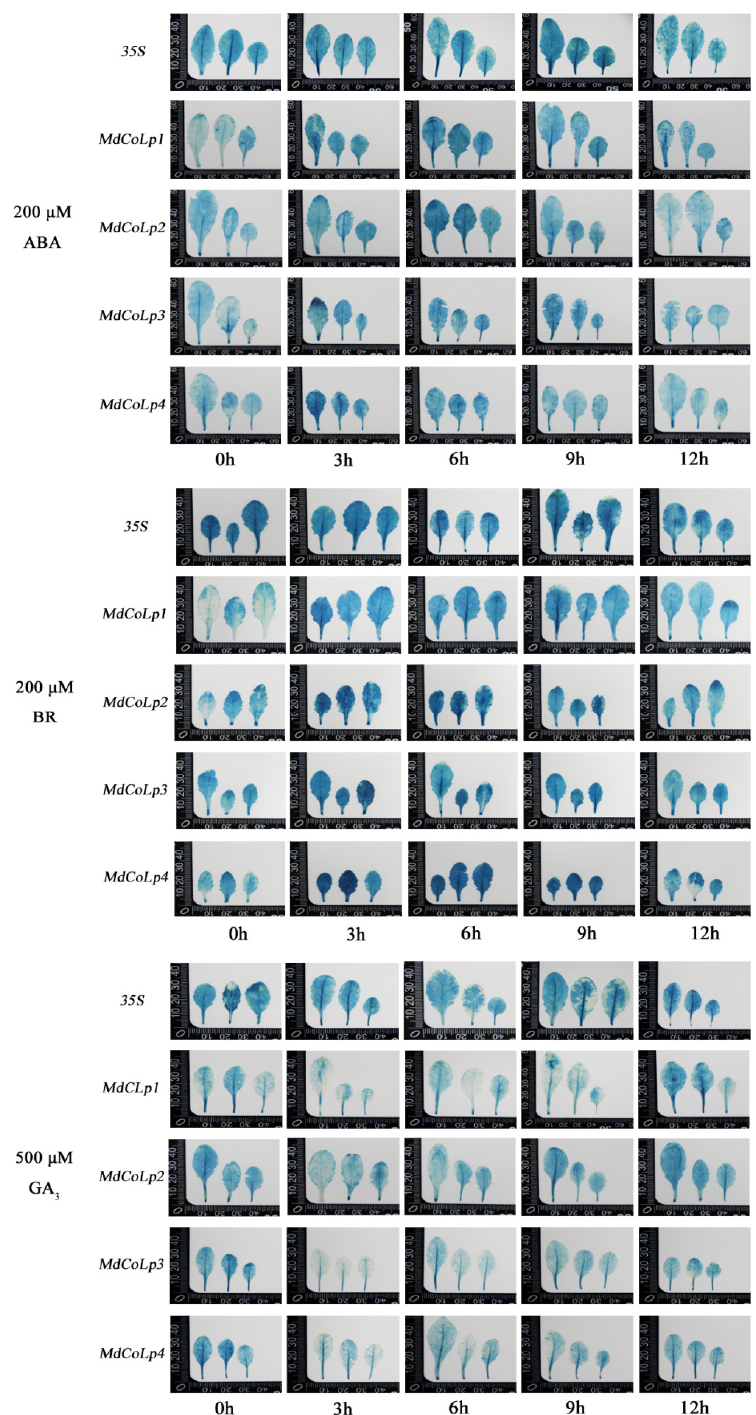
Figure 6. Effect of exogenous hormones treatment on the GUS histochemical staining of transgenic Arabidopsis plants transformed with the construct of MdCoLp1/2/3/4::GUS and 35S::GUS. The leaves used for 200 μM ABA, 200 μM BR and 500 μM GA 3 treatment were rosette leaves of trans- genic Arabidopsis growing normally for 30 days. A set of three leaves represent three transgenic Arabidopsis lines, respectively.